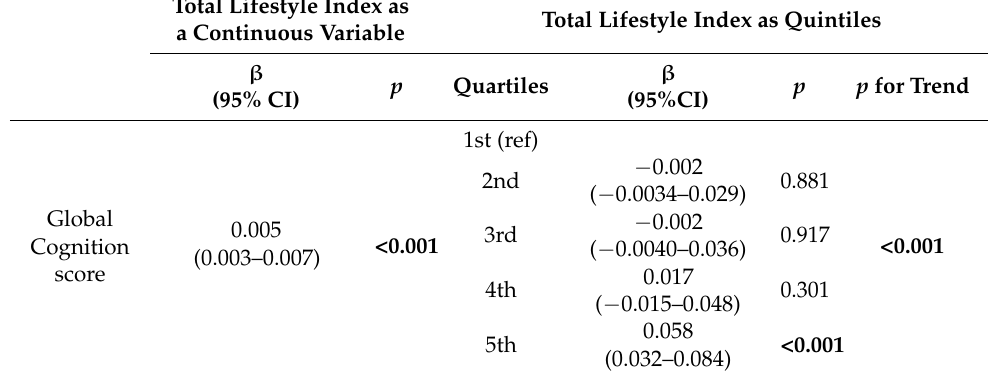
Table 2. Results from Generalized Estimating Equations assessing the association between Total Lifestyle Index as a continuous variable and as quintiles (independent variables) with differential rates of the Global Cognition score over time (dependent variables) in non-demented participants at baseline. Total Lifestyle Index as a Continuous Variable Total Lifestyle Index as Quintiles β (95% CI) β p p for Trend p Quartiles (95%CI)